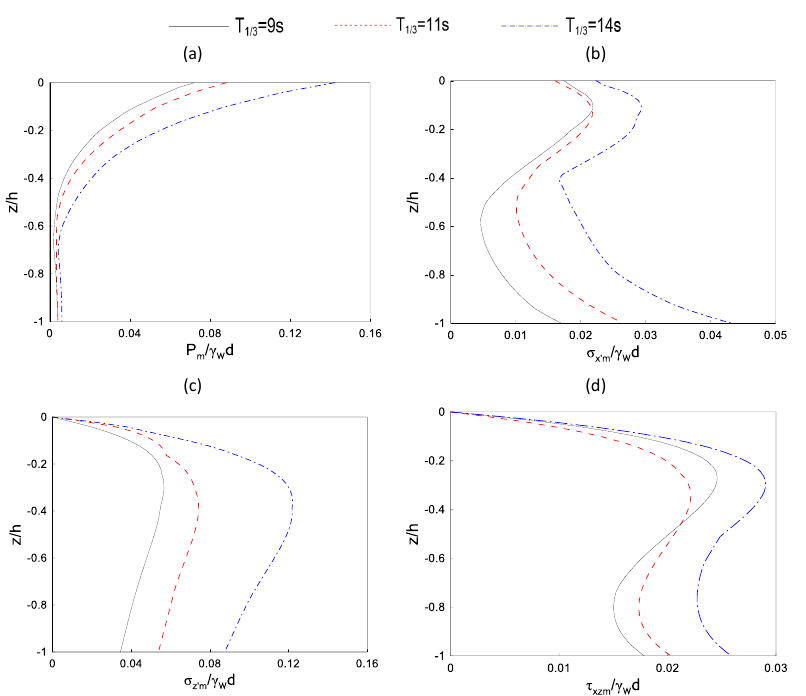
Figure 22. Distribution of the maximum soil response under the random wave with various wave pe- riods. ( a ) pore-water pressures ( p m / γ w d ); ( b ) horizontal effective normal stress ( σ (cid:48) xm / γ w d ); ( c ) vertical effective normal stress ( σ (cid:48) zm / γ w d ); and ( d ) shear stress ( τ xzm / γ w d ).